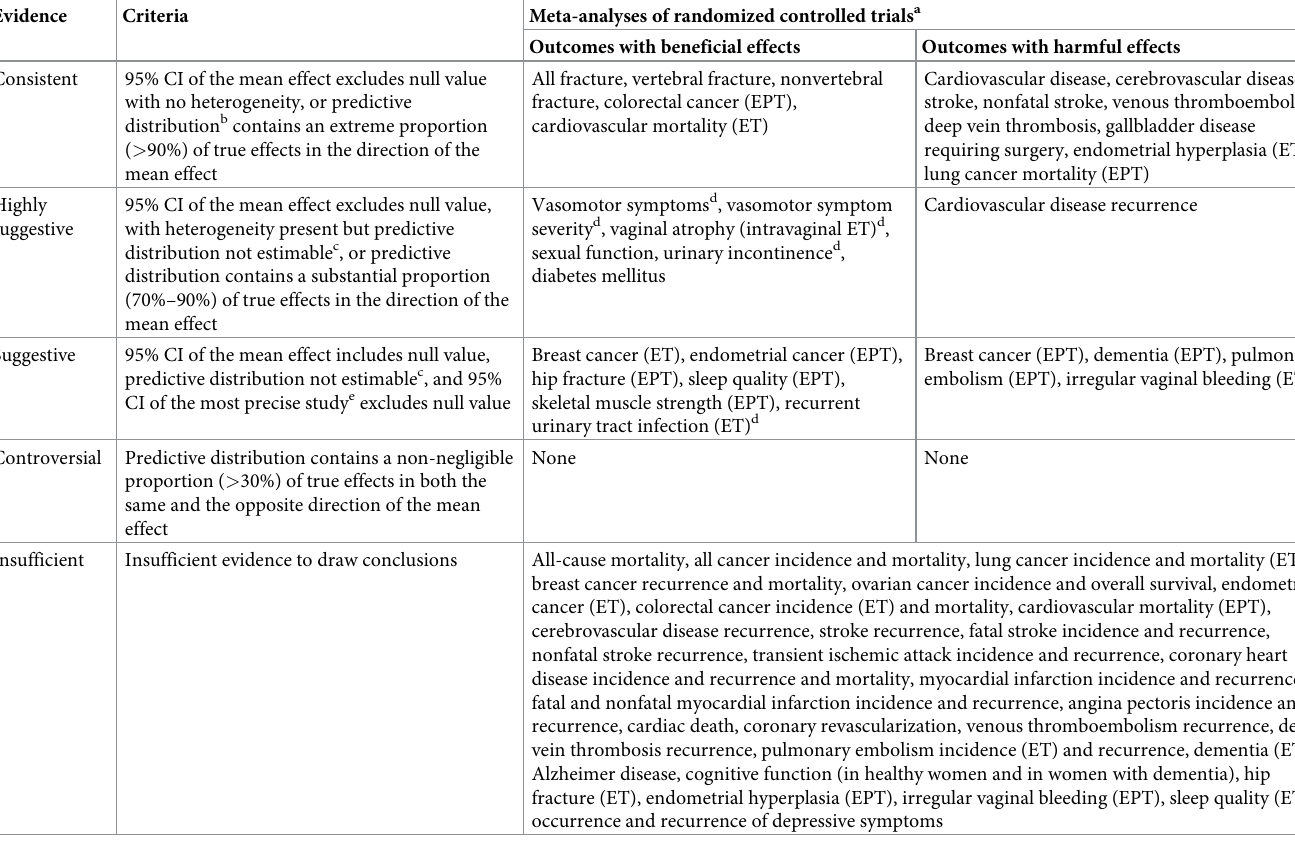
Table 1. Summary of evidence grading for meta-analyses of randomized controlled trials on menopausal hormone therapy and incidence of diseases and other health outcomes. Evidence Criteria Meta-analyses of randomized controlled trials a Outcomes with beneficial